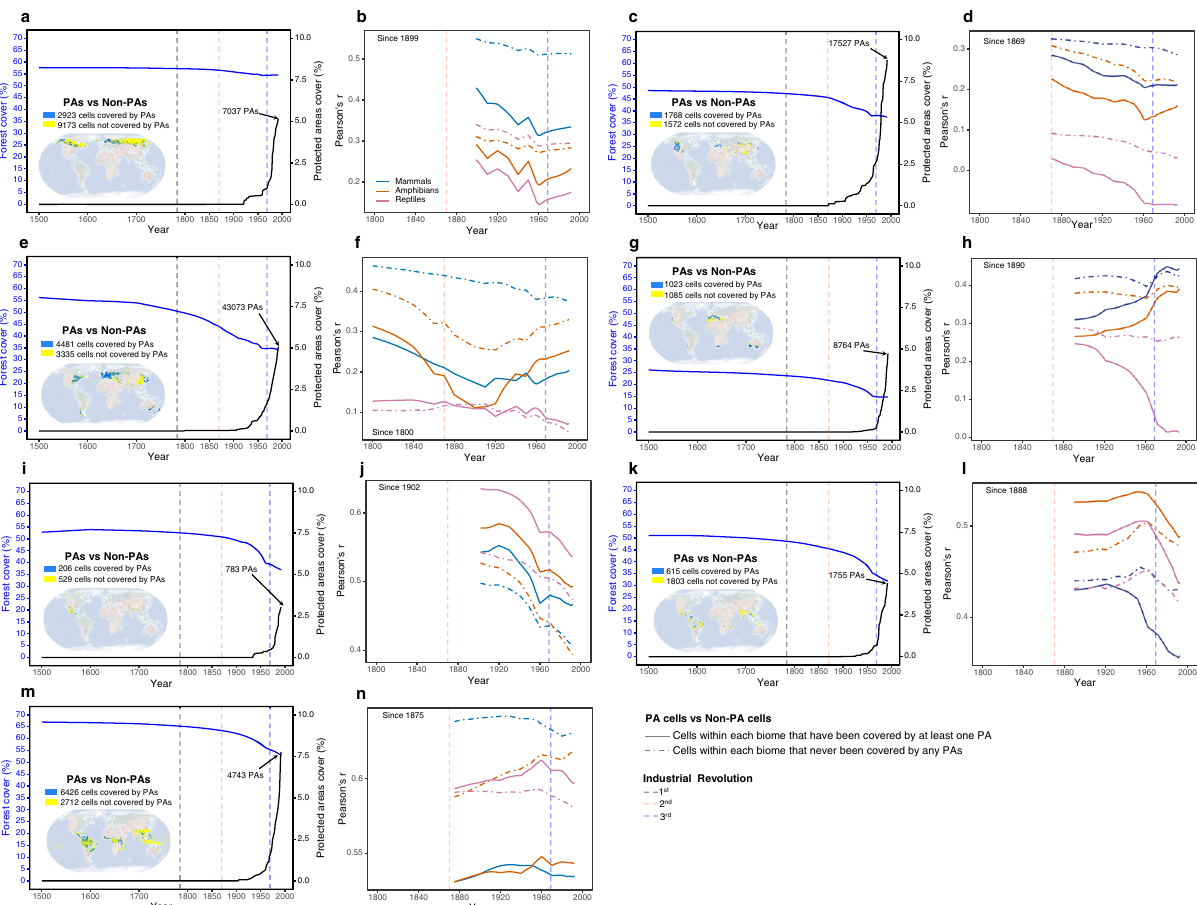
Fig. 4 Temporal dynamics of regional protected areas, forest cover and correlation coef fi cients. The yearly percentage area change in forest cover and the change in the number of protected areas in seven forested biomes ( a , c , e , g , i , k , m ). Comparisons of the changes in correlation coef fi cients (Pearson ’ s r) between the cells within each biome that were covered by at least one protected area and the cells that had never been covered by any protected area b , d , f , h , j , l , n . The seven forested biomes correspond to boreal forests/Taiga a , b , temperate conifer forests c , d , temperate broadleaf & mixed forests e , f , Mediterranean forests, woodlands & scrub g , h , tropical & subtropical coniferous forests i , j , tropical & subtropical dry broadleaf forests k , l and tropical & subtropical moist broadleaf forests m , n